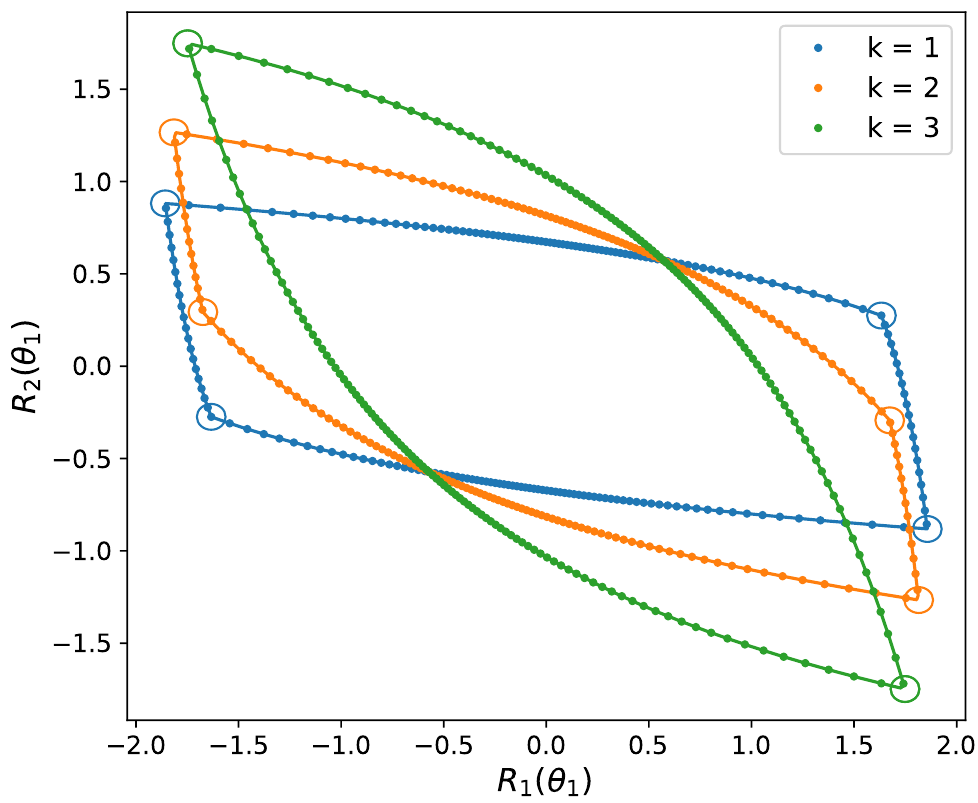
Figure 9 . Plot of the ( R 1 ( θ 1 ) , R 2 ( θ 1 )) allowed region for the pYB model for θ 1 = 0 . 9879 i . We consider the case N = 6 , and k = 1 , 2 , 3 . In this case, the whole boundary is integrable and we can compare the numerics (dots) with the analytical result (solid lines). The curves intersect at R 1 ( θ ) = R 2 ( θ ) common to all k in the ansatz (2.3). The vertices (encircled) appear when a pole or zero enters that physical region and has to be cancelled by changing the CDD